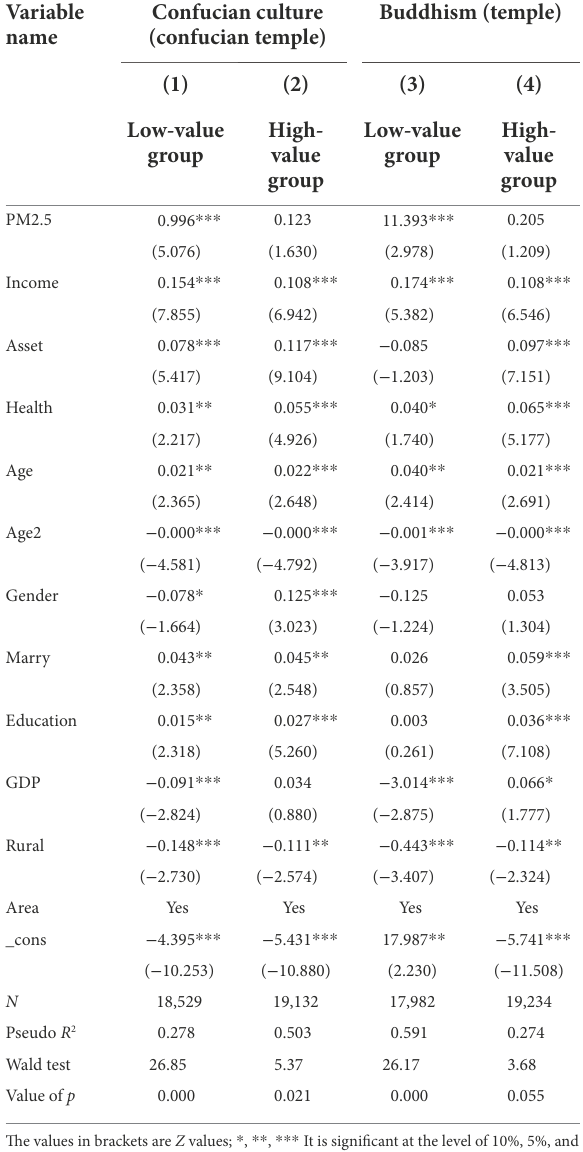
TABLE 5 The impact of haze pollution on demand for commercial health insurance: an analysis based on the infomal system. Variable